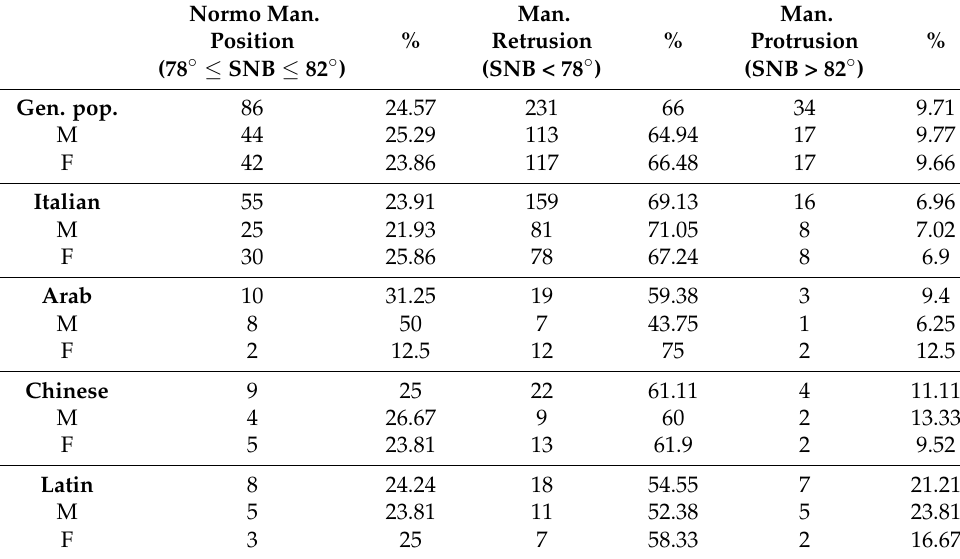
Table 5. Distribution of mandibular position in the selected patient sample.